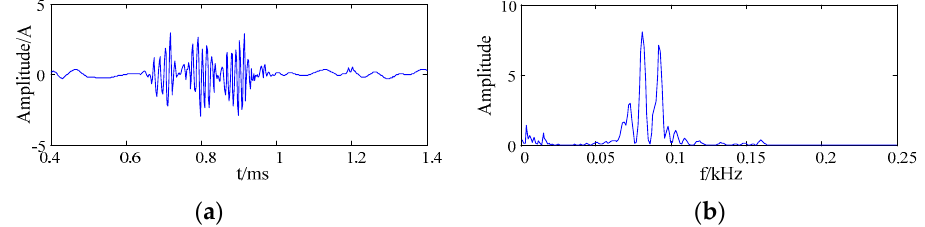
Figure 7. The waveform and spectrum after denoising by wavelet packet ( a ) the waveform; ( b ) the frequency spectrum